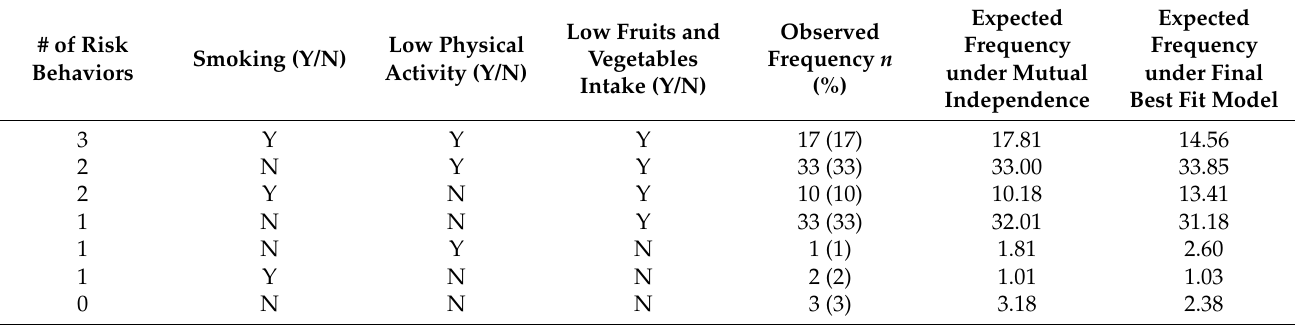
Table 5. Clustering of health risk behaviors among Mexican men ( n =